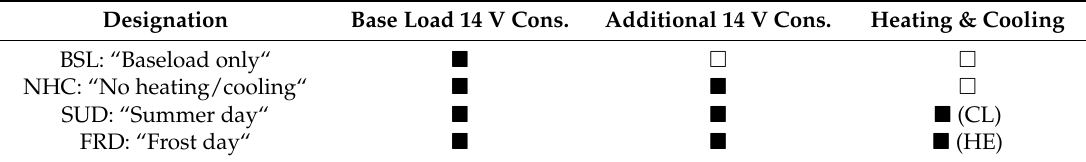
Table 10. Definition of load cases. For the definition of NHC, SUD and FRD cases, see Table 7; HE: heating element; KL: AC compressor. For a list of electric consumers, see Table 3.